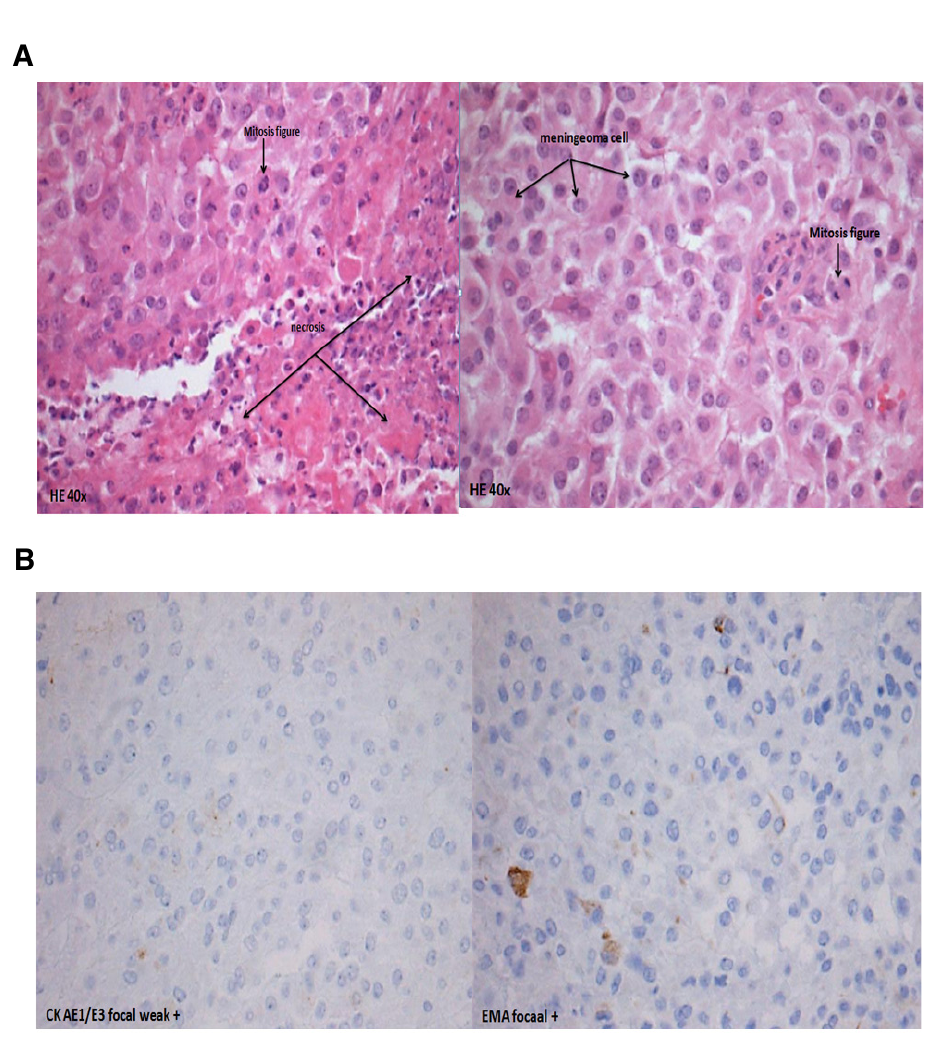
Figure 2. Histology staining of a biopsy of the solid intrathoracal lesion showing the same morphology as the intracranial meningioma. A : A specimen (HE-stained, 40x) showing histological resemblance between the intrathoracal lesion and the intracranial meningioma. B : Specimen (focal plus and focal weak) showed high expression in the EMA-staining and also in the